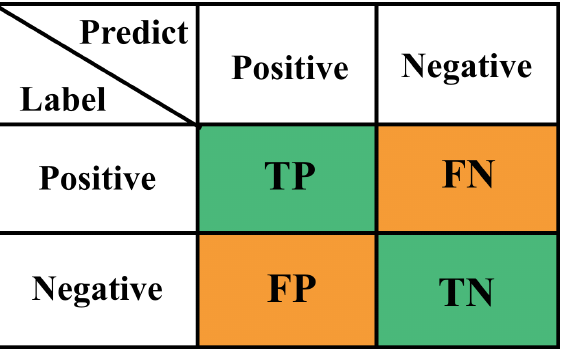
Figure 9. Confusion matrix with binary classification